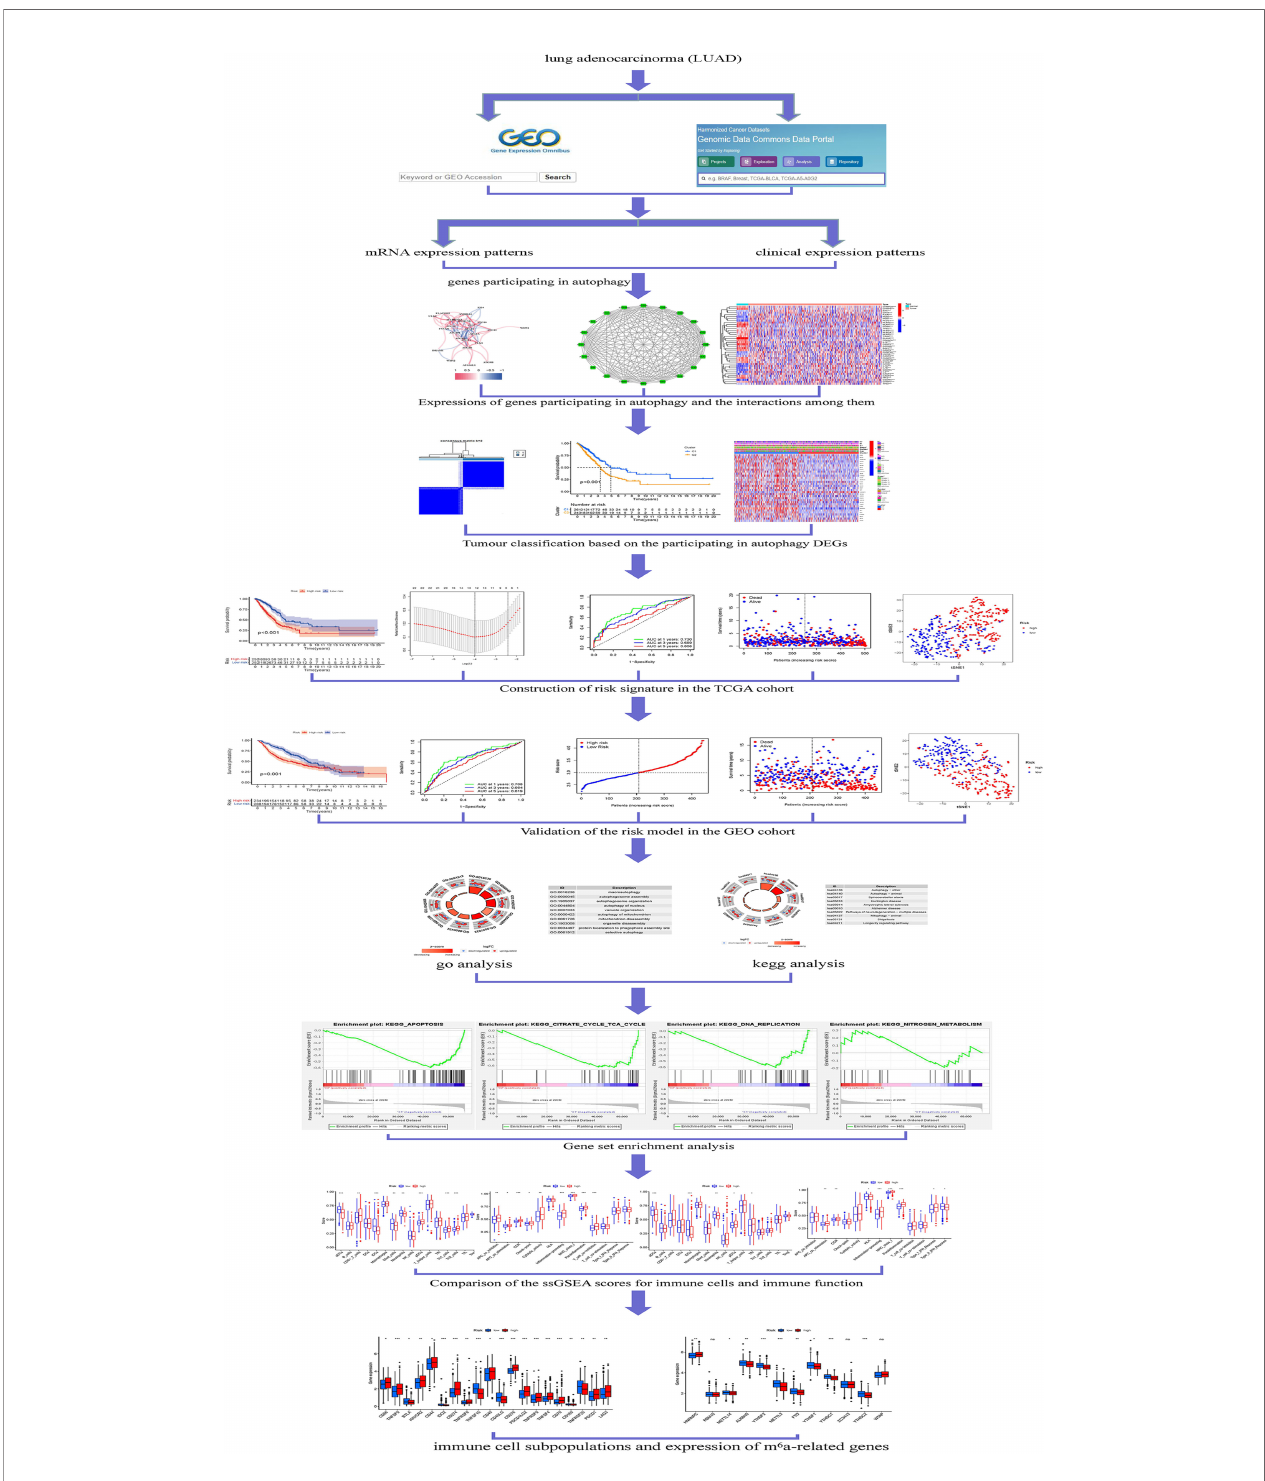
FIGURE 1 | Framework based on an integration strategy of genes participating in autophagy. The data of LUAD patients were obtained from TCGA and GEO databases, and then the autophagy-related genes were matched to carry out difference analysis and risk model construction, respectively. TCGA dataset was used as the main body and GEO dataset was used to verify the model with good grouping, and genes participating in autophagy related to the prognosis of LUAD patients were obtained. Then, Gene Ontology (GO), Kyoto Encyclopedia of Genes and Genomes (KEGG), and gene set enrichment analysis (GSEA) were performed with multiple databases to obtain the functions related to genes participating in autophagy. Last, the immune cells and function were analyzed. *P < 0.05; **P < 0.01; ***P < 0.001.